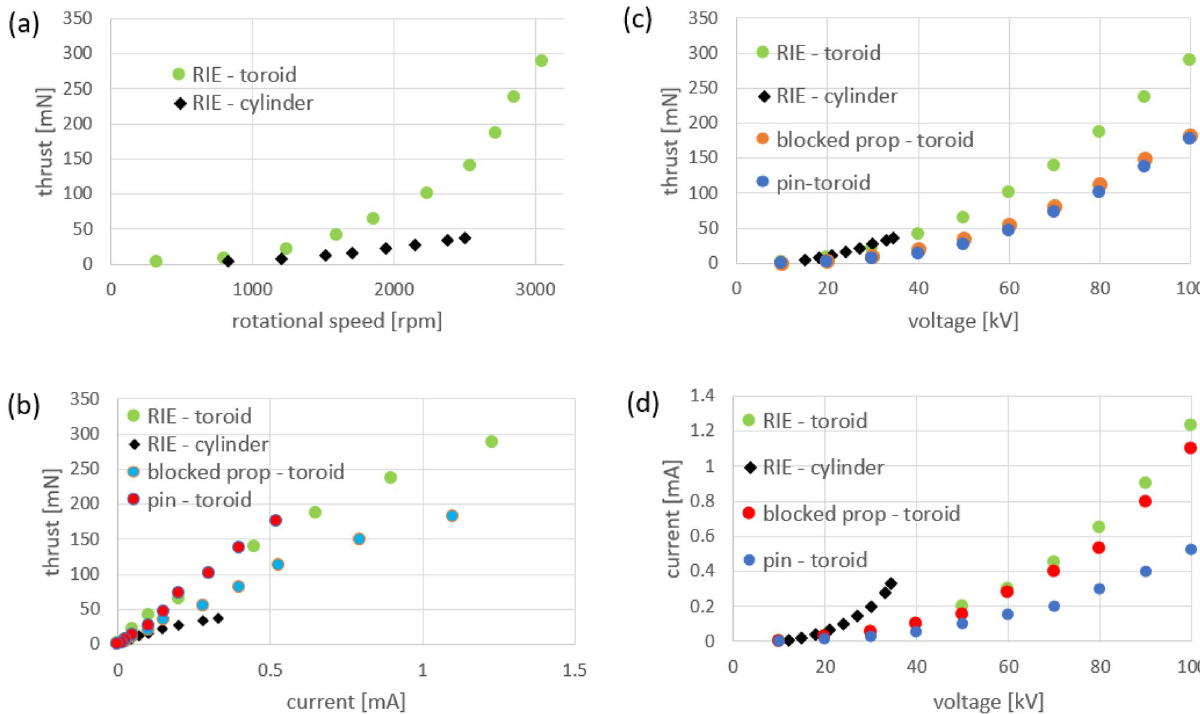
Figure 5. Thrust measurements in ionic systems with toroidal and cylindrical counter electrodes (the toroid minimum diameter is 17 cm and equal to the cylinder electrode). ( a ) Variation of the ionic axial thrust with rotational speed in RIEs with toroidal and cylindrical counter electrodes ( b ) Variation of the ionic axial thrust with current in RIEs with toroidal and cylindrical counter electrodes; additional comparison is made for systems with a blocked ionic propeller and for systems using the shaft/pin as emitter. ( c ) Variation of the ionic axial thrust with voltage ( d ) Current–voltage characteristics of the studied